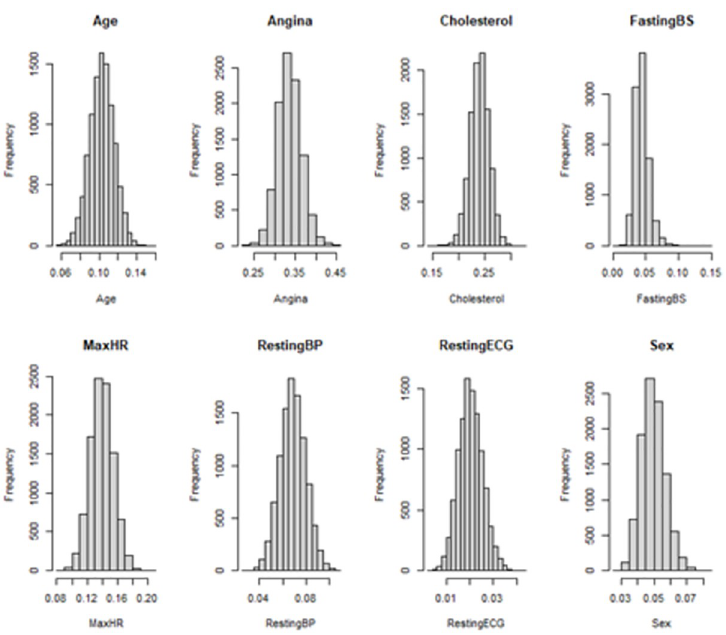
Fig 4. Gain statistics summary. For the XGBoost models, the distribution of th gain statistic for all covariates: Age, Angina, Cholesterol, Fasting Blood Sugar (Fasting BS), Maximum Heart Rate (MaxHR), Resting Blood Pressure (RestingBP), Resting electrocardiogram (RestingECG),